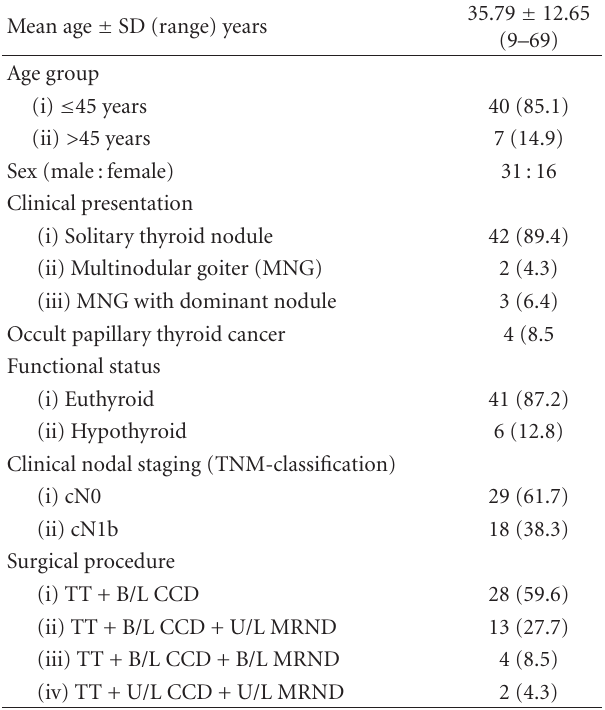
Table 1: Demographic profile of the patients; n = 47 (% age). Mean age ± SD (range)